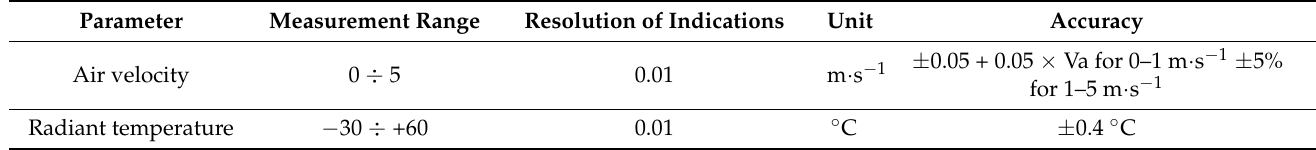
Table 1. Microclimate measurement specifications.